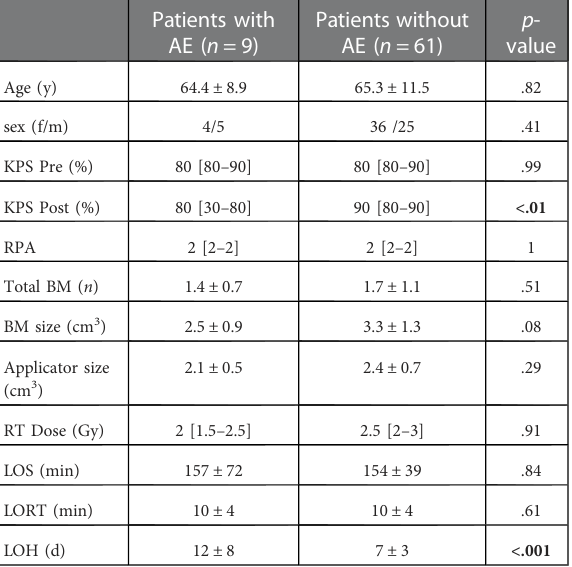
TABLE 4 Comparison patients with/without AE: y, years; f/m, female/ Male; KPS, Karnofsky performance score; Pre, preoperative; post, postoperative; RPA, recursive partitioning analysis; y/n, yes/no; BM, brain metastasis; n , number; RT, radiotherapy; Gy, gray; LOS, length of surgery; LORT, length of radiotherapy; AE, adverse event; LOH, length of hospitalization; d, days; data is shown as [mean±SD/ median (interquartile range)] with level of signi fi cance p